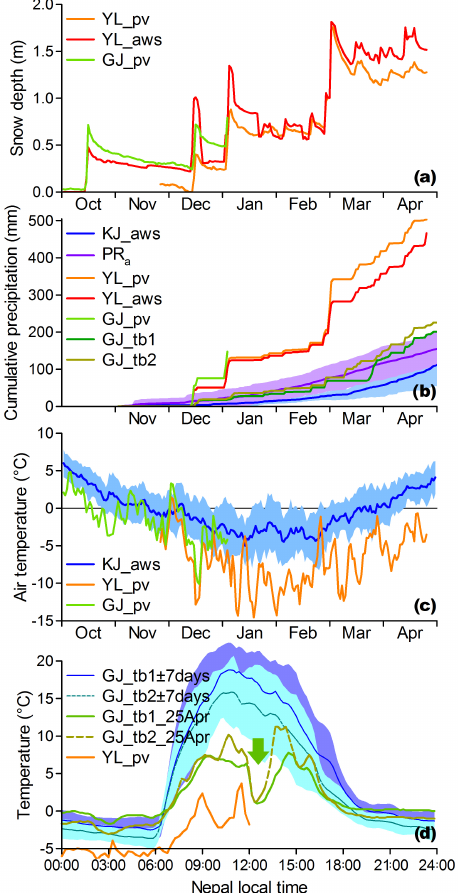
Figure 10. (a) Snow depth, (b) cumulative precipitation, and (c) air temperature observed at meteorological sites in Langtang Valley un- til the Gorkha earthquake (25 April 2015). Blue lines with shad- ings in (a) and (c) denote long-term means observed at Kyangjin (KJ_aws, 1988–1992, 2002–2008, 12 years in total). Purple line with shading in (a) denotes long-term means of Aphrodite precipi- tation at a grind including Kyangjin (PRa, 1978–2007, 29 years in total). (d) Diurnal temperatures recorded by a sensor embedded in a tipping bucket at two Gangja La sites. Thick green lines and thin blue lines with shadings denote temperatures on 25 April 2015, the date when the Gorkha earthquake occurred, and means created from weeks before and after the earthquake (14 days in total but exclud- ing 25 April). Also shown is air temperature recorded at Yala site (orange line), which was destroyed by wind blast or dense flow. Lo- cations of the site are shown with abbreviations in Fig. 1a. Green arrow in (d) denotes the temperature drop after the